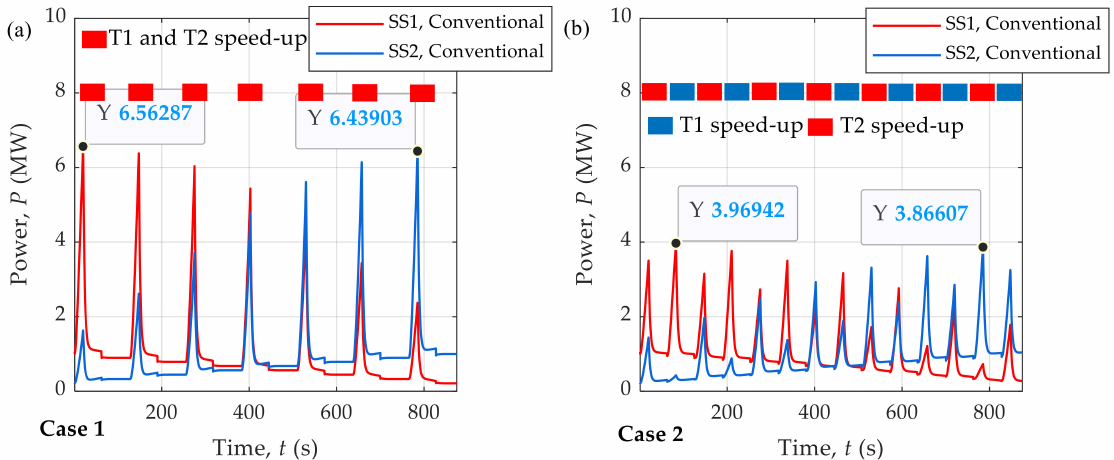
Figure 18. Instantaneous power supplied by the two substations SS1 and SS2 for the conventional cable. ( a ) Scenario 1, same speed profile with the trains leaving the SS at the same time; ( b ) scenario 2, same speed profile shifted in